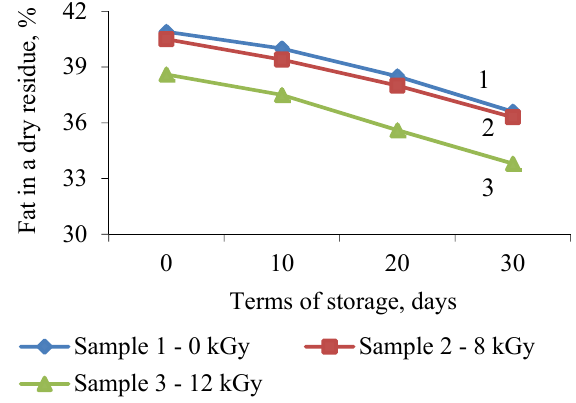
Fig. 9. Dynamics of fat in the dry residue in the control and experimental samples of the refrigerated pork neck on the bone packed using MAP during storage.